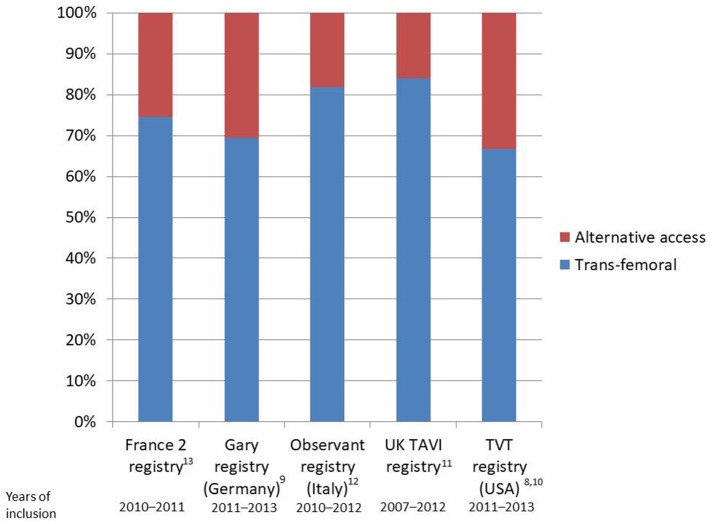
Bar plot reporting rates of transfemoral implants as compared to alternative accesses in national registries.